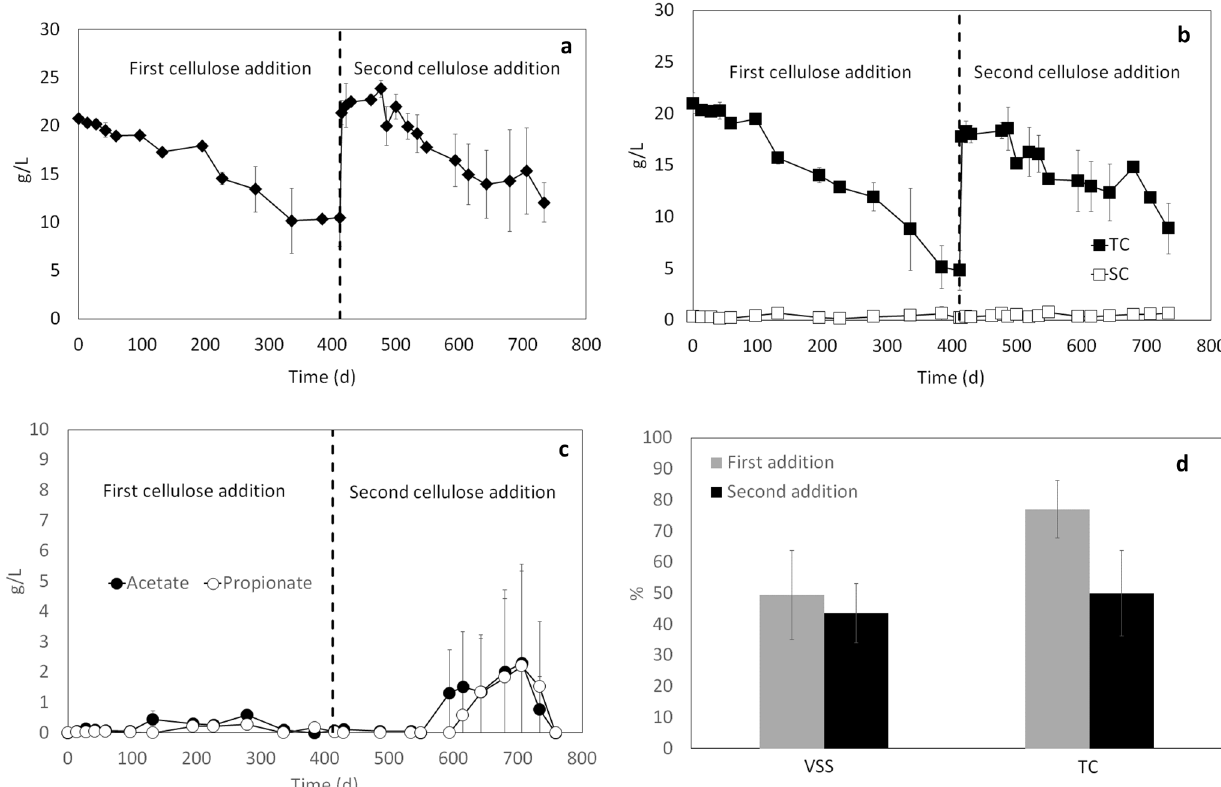
Fig. 2 Experimental data for Run A. a VSS; b TC and SC; c Liquid-phase products; d removal at the end of the first and second cellulose addi- tion. The error bars indicate the standard deviation of two replicate